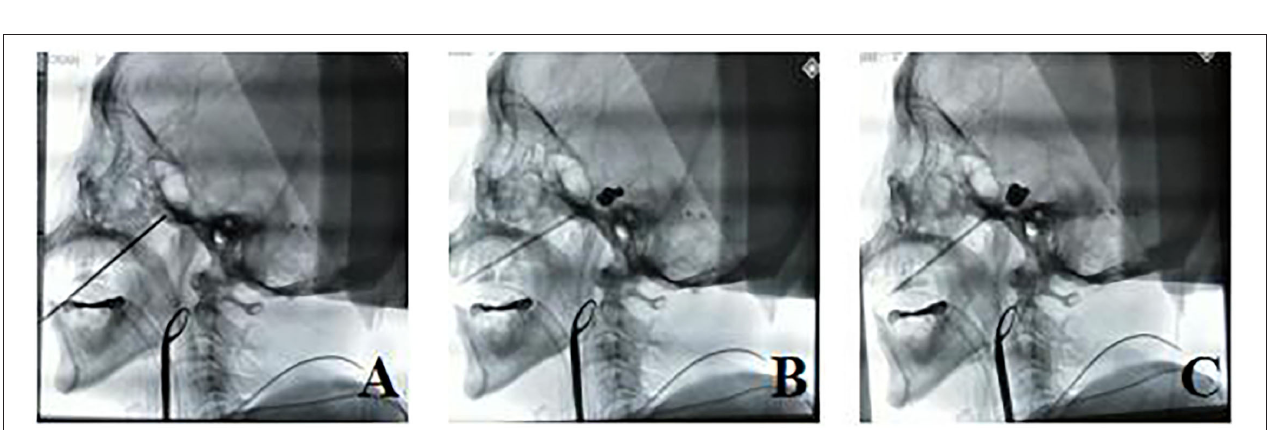
FIGURE 2 | (A–C) After the puncture was in place during the operation, the balloon was filled, and the puncture point had to be inside Meckel’s cave and formed an effective “pear” shape.